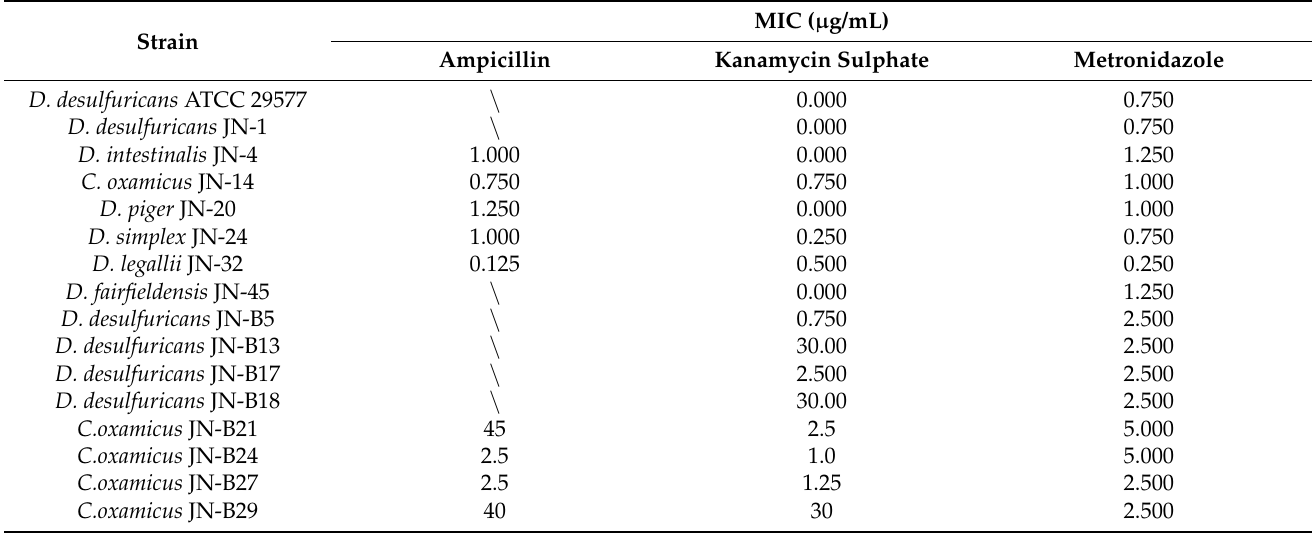
Table 2. The minimum inhibitory concentration (MIC) of antibiotics for Desulfovibrio from the human